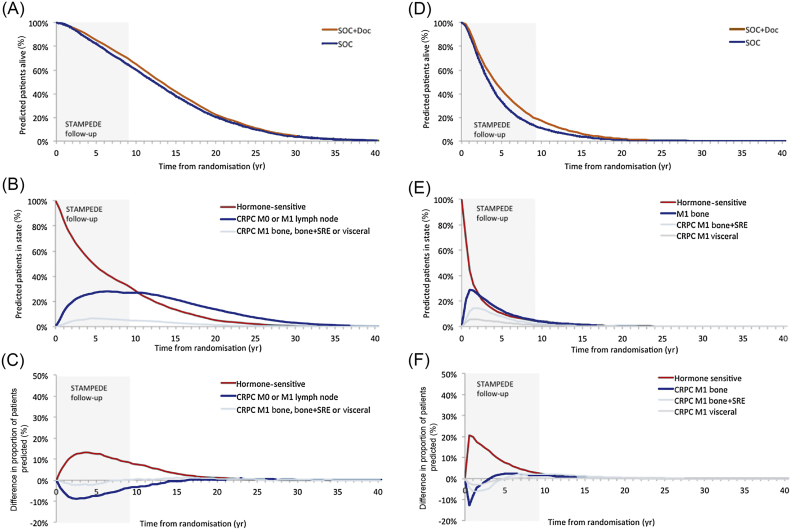
Predicted patient prognosis over time. (A) Overall survival for patients with M0 disease. (B) Proportion of patients with M0 disease receiving standard of care (SOC) by health state. (C) Difference in proportion of patients with M0 disease in each health state (SOC + docetaxel (Doc) minus SOC). (D) Overall survival for patients with M1 disease. (E) Proportion of patients with M1 disease receiving SOC by health state. (F) Difference in proportion of patients with M1 disease in each health state (SOC + Doc minus SOC). CRPC = castrate-resistant prostate cancer; SRE = skeletal-related event, M0 = nonmetastatic, M1 = metastatic. The grey shaded area denotes the duration of patient follow-up in STAMPEDE.